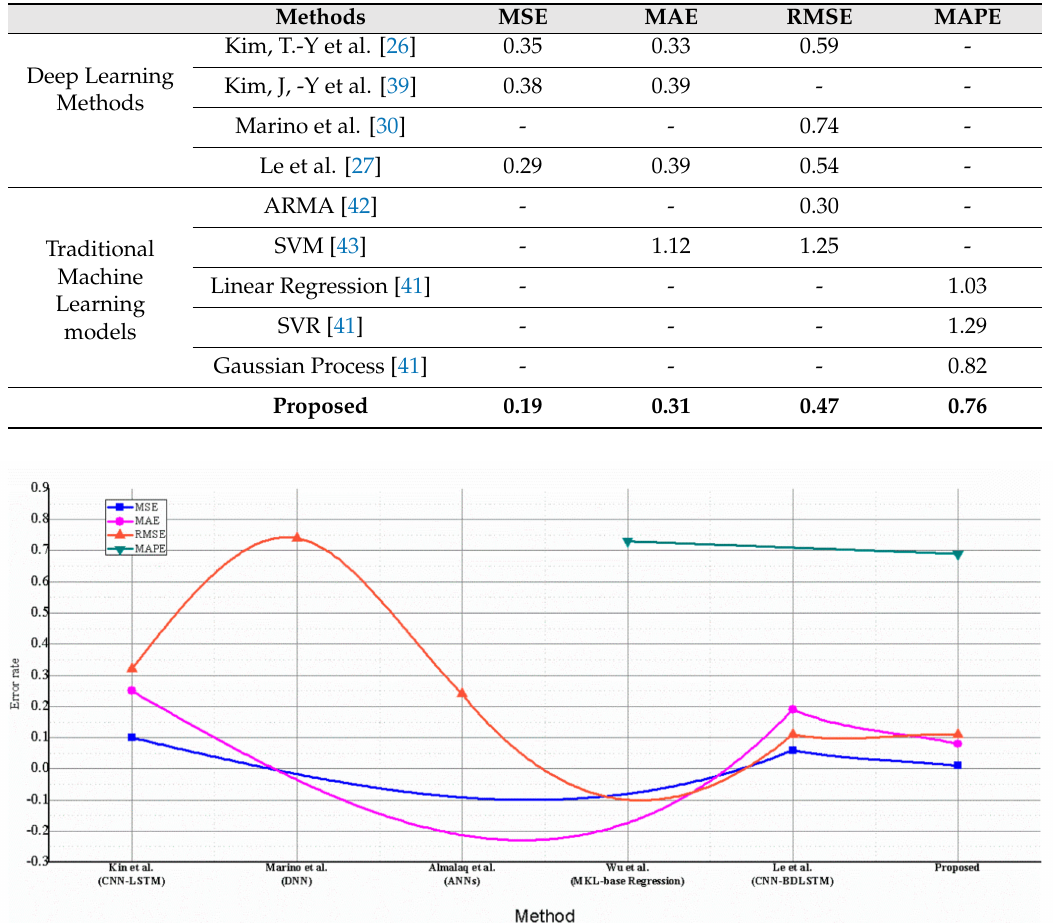
Table 3. The comparative analysis of the proposed method with other state-of-the-art Deep Learning and traditional techniques for hourly data resolution.